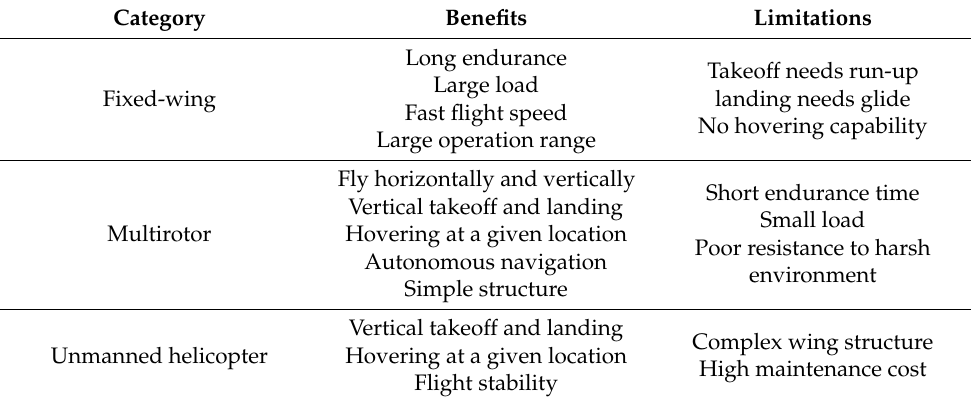
Simple structure